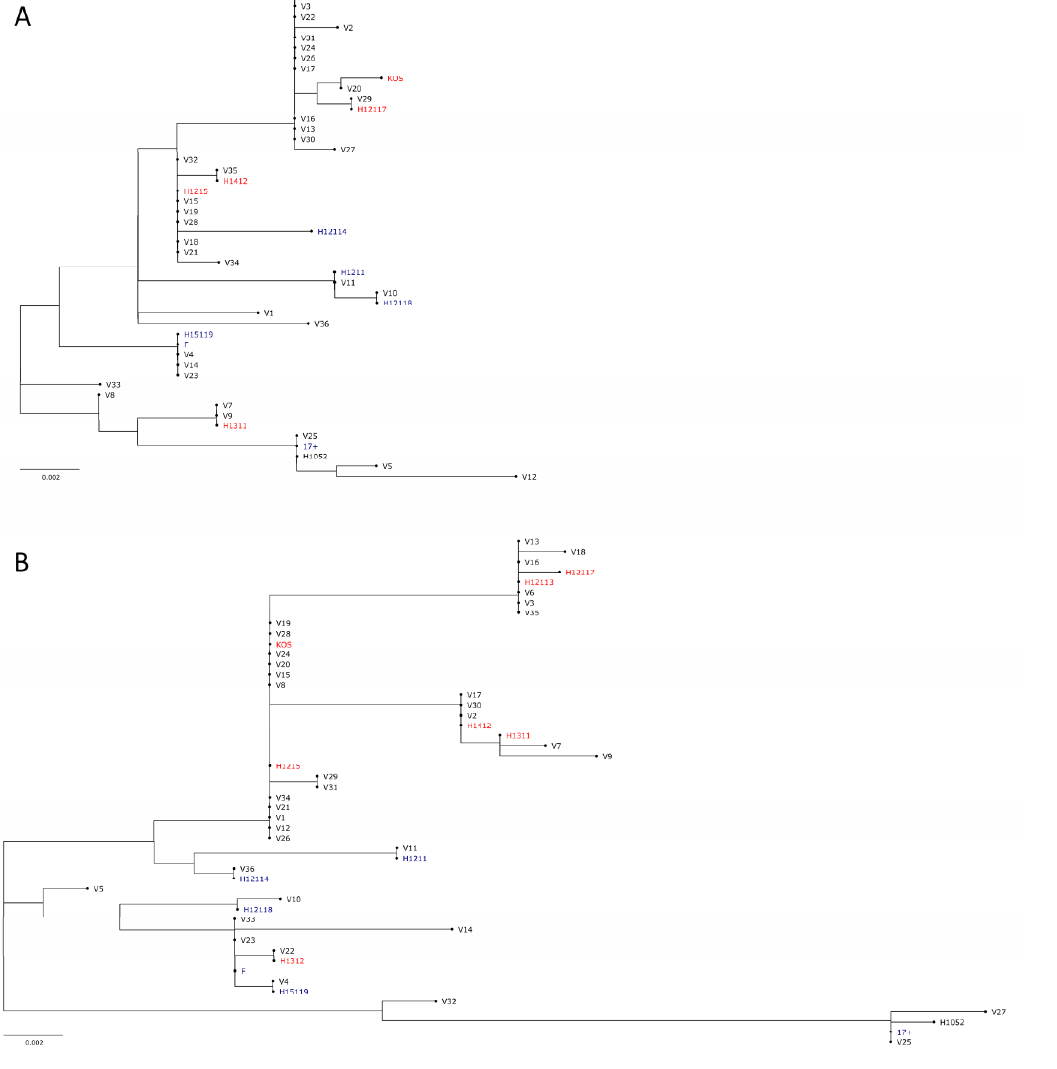
Figure 4. Genotypic relatedness of the studied strains by UL27 and US7 genes. Phylogenetic trees were constructed based on partial sequencing of the ( A ) UL27 gene and the ( B ) US7 gene, coding for gB and gI, respectively. All clinical isolates, F, KOS, 17+, and H1052 were sequenced. Additionally, previously full genome sequenced Finnish strains [3] were included in the analysis. For UL27, nucleotides 55,132–55,897 and for US7, nucleotides 140,222–140,960, were sequenced according to the numbering of Genbank submission JN555585.1 (HSV-1 strain 17+). The sequences were aligned with ClustalW-algorithm and the phylogenetic trees were created in ML-tree format utilizing the Bootstrap method with 1000 replicates. Strains with previously assigned Asian or European/North American clades [3] are colored with red or blue,